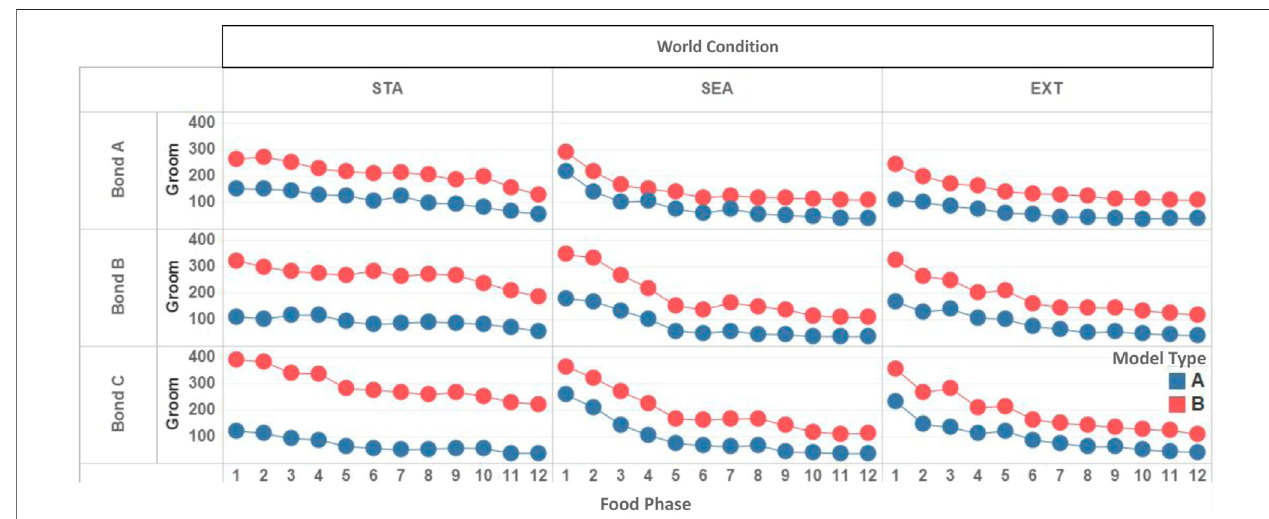
FIGURE 11 | Temporal dynamics of total intra-bond Grooming between bonded agents in each world condition (STA = Static, SEA = Seasonal, EXT = Extreme) across 20 simulation runs, for both Type BV (blue) and Type BV+ST (red) models.